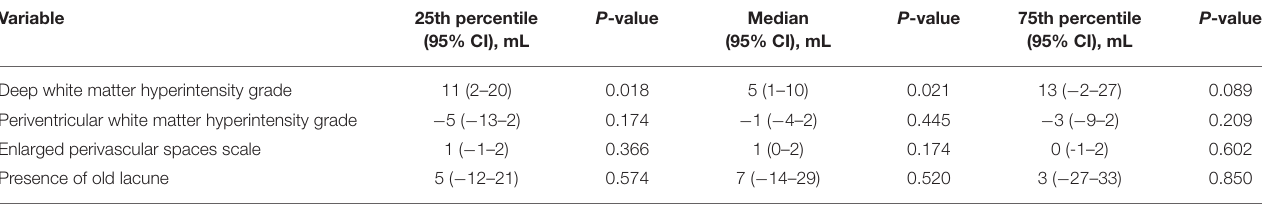
TABLE 3 | Brain volume change and small vessel disease imaging markers, adjusted for baseline brain volume (positive numbers indicate decrease in volume).